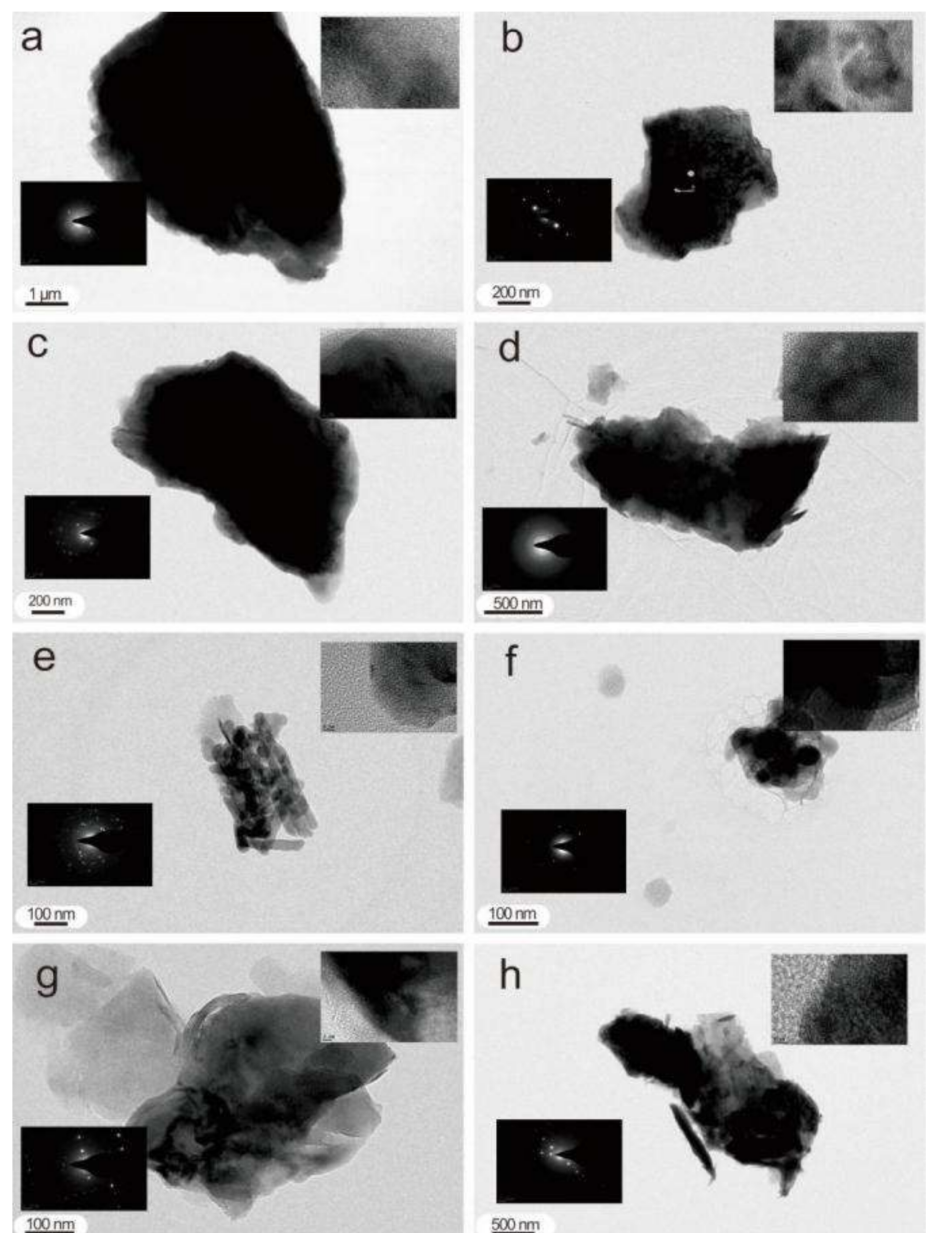
Figure 10. TEM photomicrograph of particles or aggregations in the ( a – c ) ascending gas flow and ( d – h ) in the soil. ( a ) TEM image, SAED pattern and HRTEM image of an Mg-, Si-bearing aggregation (IDB1). ( b ) TEM image, SAED pattern and HRTEM image of a Mg-, Al-, Si, Ca-, Fe-bearing particle (IDB2). ( c ) TEM image, SAED pattern and HRTEM image of a Si-, Ca-bearing aggregation (IDB3). ( d ) TEM image, SAED pattern and HRTEM image of a Mg-, Al-, Si-, K-, Ca-, Fe-bearing particle (IDB4). ( e ) TEM image, SAED pattern and HRTEM image of a Mg-, Al-, Si-, Ca-, Fe-bearing particle (IDB5). ( f ) TEM image, SAED pattern and HRTEM image of a Si-, Fe-bearing particle (IDB6). ( g ) TEM image, SAED pattern and HRTEM image of a Ca-bearing particle (IDB7). ( h ) TEM image SAED pattern and HRTEM images of an Fe- and Pb-bearing aggregation